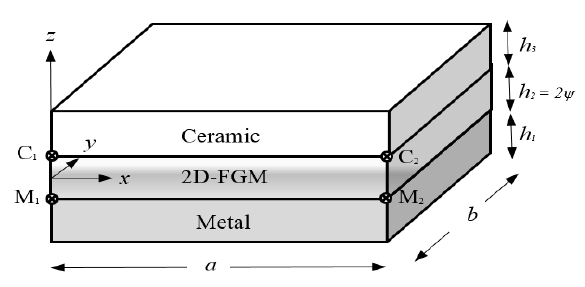
Fig. 1. Geometry of the 2D-FGM sandwich plate